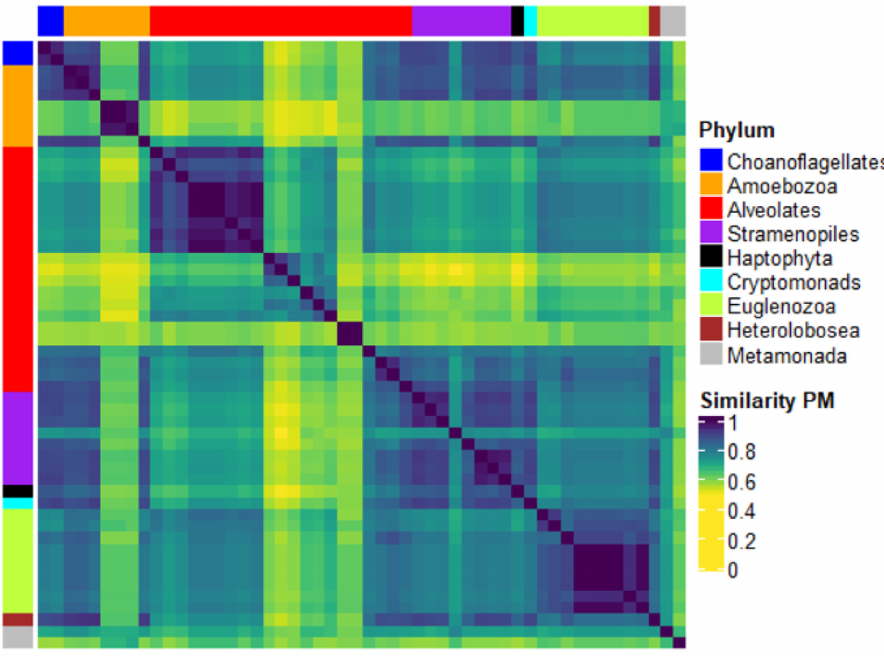
Fig 7. Heatmap of the PM similarity matrix of the KEGG Protists (left) and composition of clusters w.r.t. a total of four clusters for the PM graph kernel.